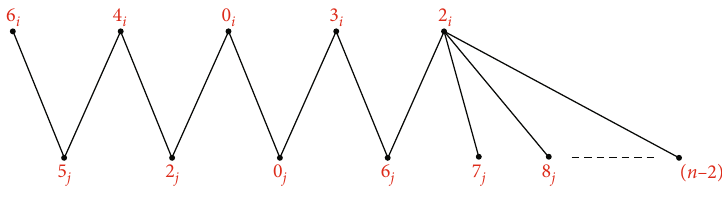
1, 0, 0, 0, 0, 0, 0, n − 8 ÞÞ i , j : 8 ð